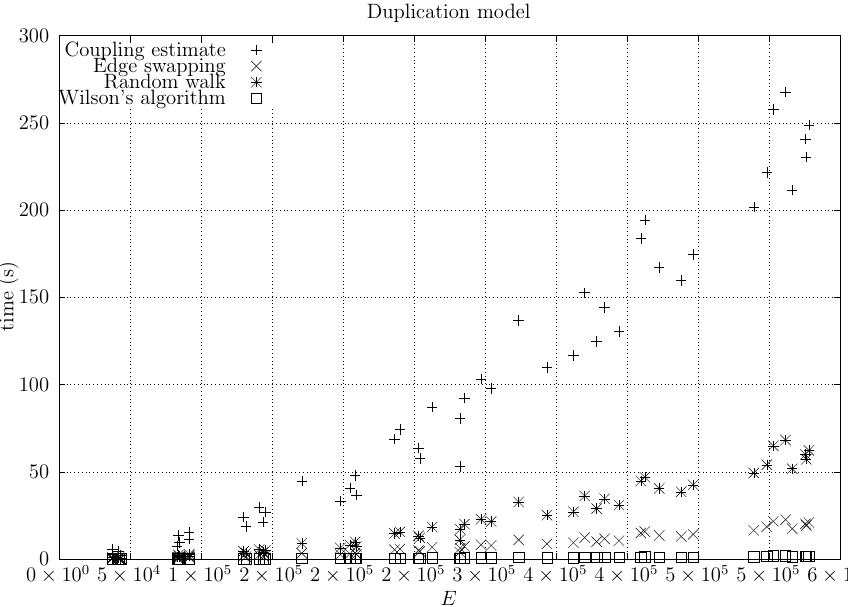
Figure 32. Running times for dmP graphs averaged over five runs, including the running time for computing the optimistic coupling estimate, the running time for generating a spanning tree based on that estimate, the edge-swapping algorithm, the running time for generating a spanning tree through a random walk, and the running time for Wilson’s algorithm.